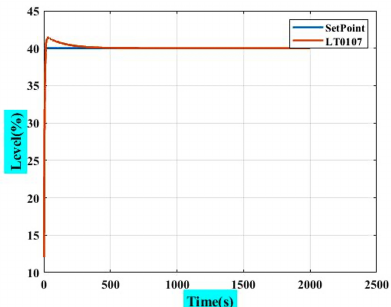
Figure 14. System response after being controlled by RL agent.